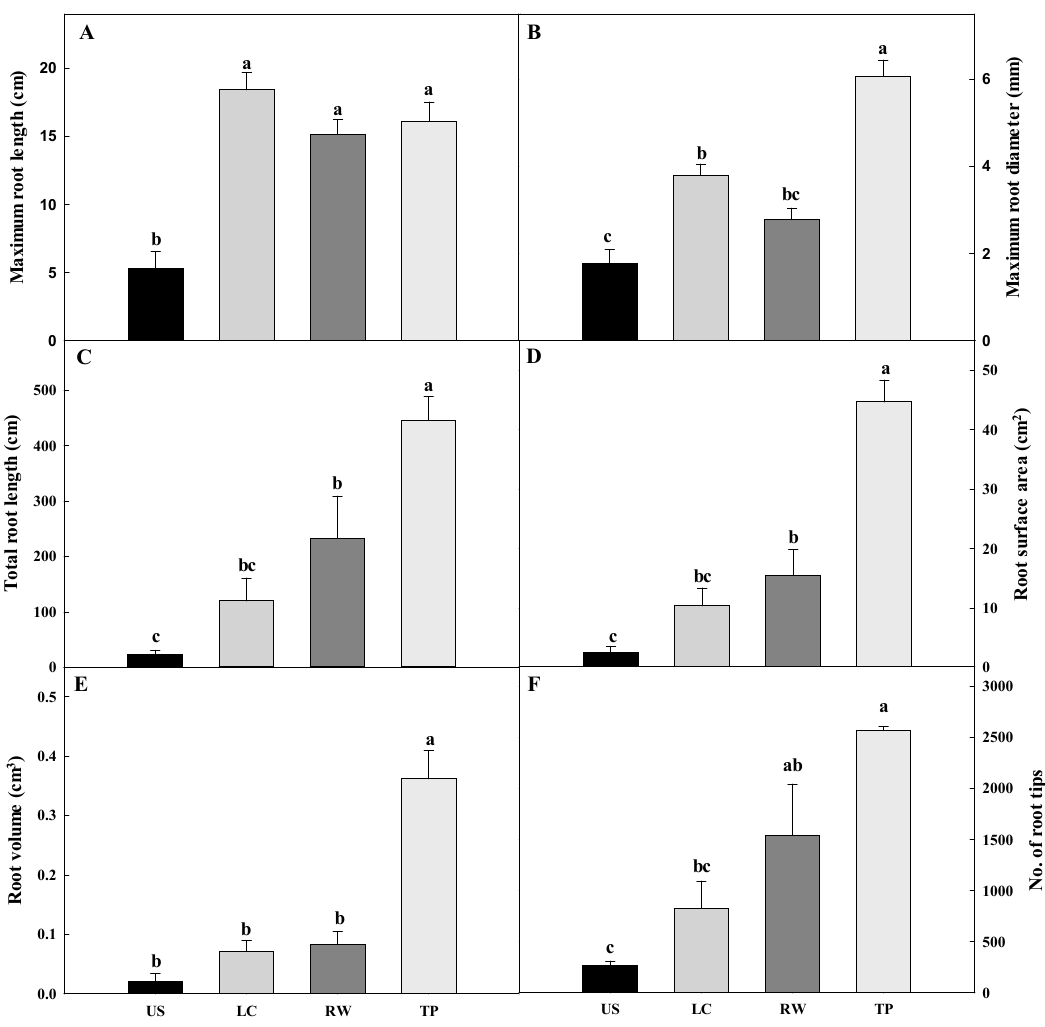
Figure 4. Maximum root length ( A ), maximum root diameter ( B ), total root length (C), root surface area ( D ), root volume ( E ), and number of root tips ( F ) of Adenophora triphylla var. japonica Hara seedlings as a ff ected by di ff erent media at 54 days after transplanting. US, urethane sponges; LC, LC grow foam; RW, rockwool; and TP, terra-plugs. Vertical bar represent the standard deviation of the mean ( n = 3). Di ff erent letters in the same column indicate significant di ff erences based on Tukey’s multiple range test ( p ≤ 0.05).